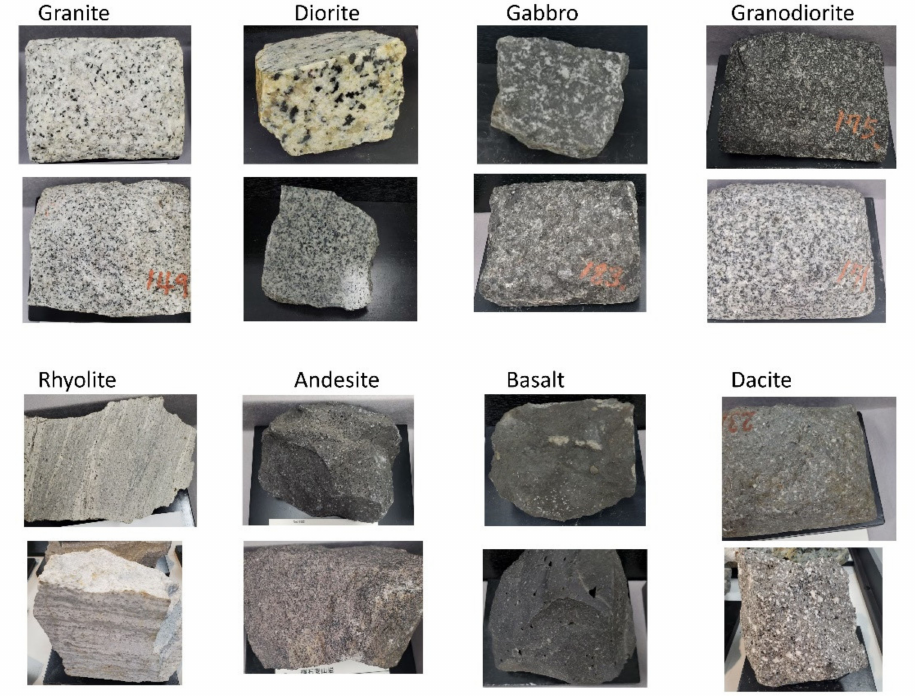
Figure 2. Images of some of the 32 rock samples from eight rock lithologies used in building our rock hyperspectral